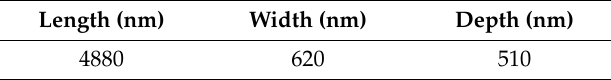
Figure 8. SEM image of a specimen fabricated for tensile testing. Table 2. Dimensions of the Al specimen.